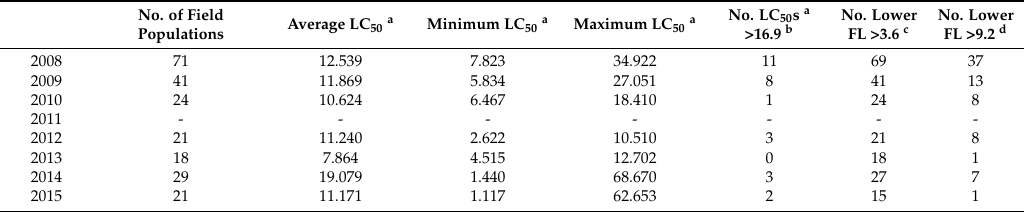
Table 3. Summary of annual responses of tarnished plant bug field population responses to acephate